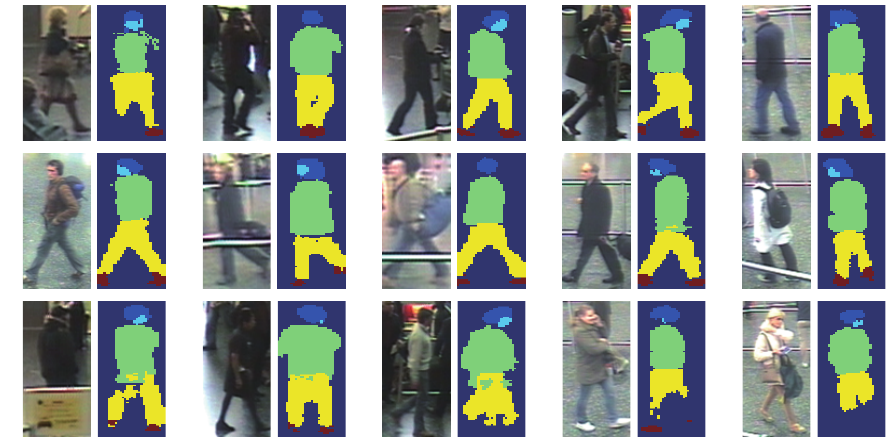
Figure 9. Some examples of person segmentation on the iLIDS-VID